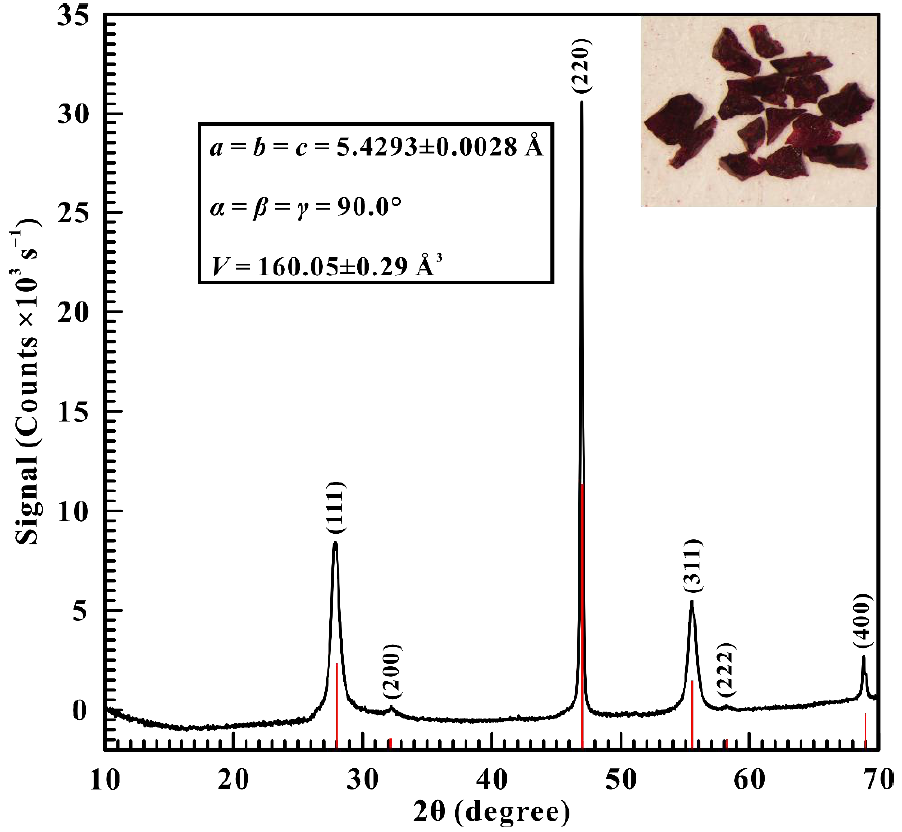
Figure 1. X-ray diffraction (XRD) pattern of the initial Ga 2 Se 3 sample. Red vertical lines present the standardized diffraction peak positions of Ga 2 Se 3 . Inset: Optical microscope image and the calculated lattice parameters for the initial sample.